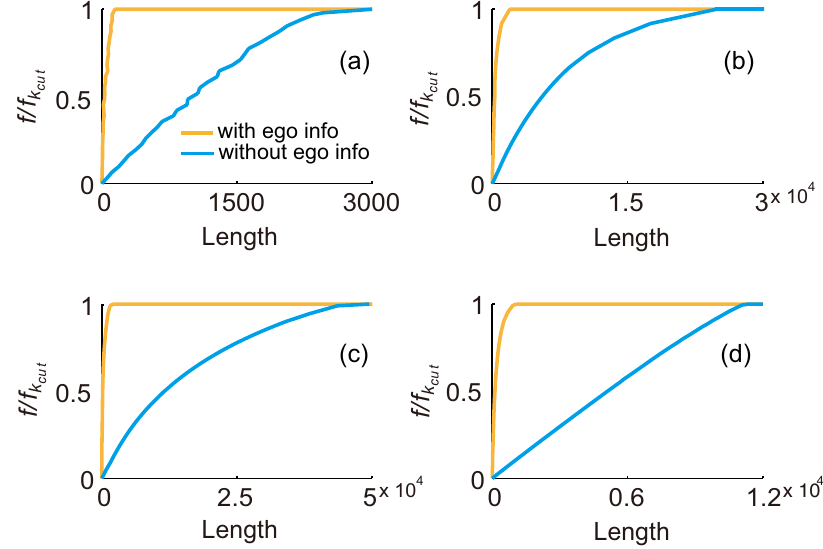
Figure 4. The length of the RDS chain from simulations that implemented the RDS strategy with and without egocentric information in ( a ) the Advogato network, ( b ) the Brightkite network, ( c ) the Epinions network and ( d ) the MSM network. f kcut refers to the fraction of nodes whose degree k ≥ k cut . The length is averaged over 100